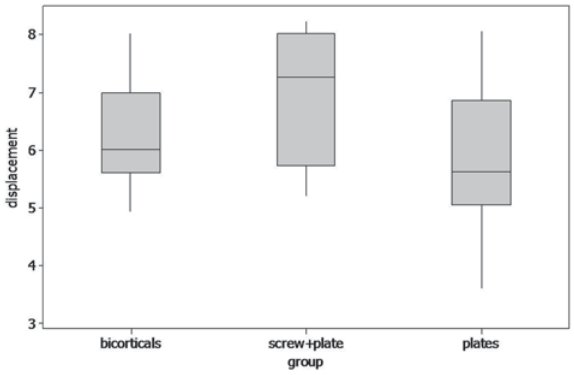
Figure 8- “Boxplot” graphic regarding maximum force for Groups I (Inverted “L”), II (Hybrid) and III (Plates), respectively Table 1- Descriptive statistical analysis of maximum force (kgf) and displacement (mm) obtained in Groups I (Inverted “L”), II (Hybrid) and III (Plates) Variable